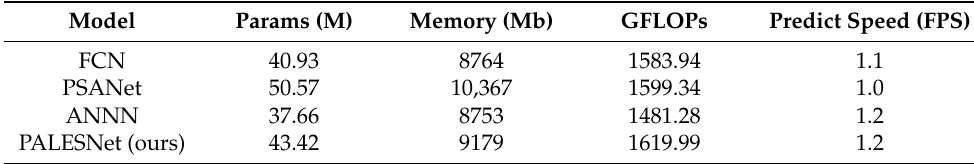
Table 5. Efficiency analysis result for each